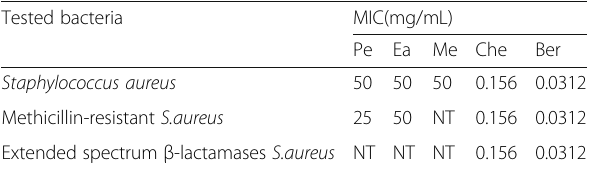
Table 3 MICs of T. asiatica fractions and chelerythrine against SA, MRSA and ESBLs-SA Tested bacteria MIC(mg/mL) Pe Ea Me Che Ber